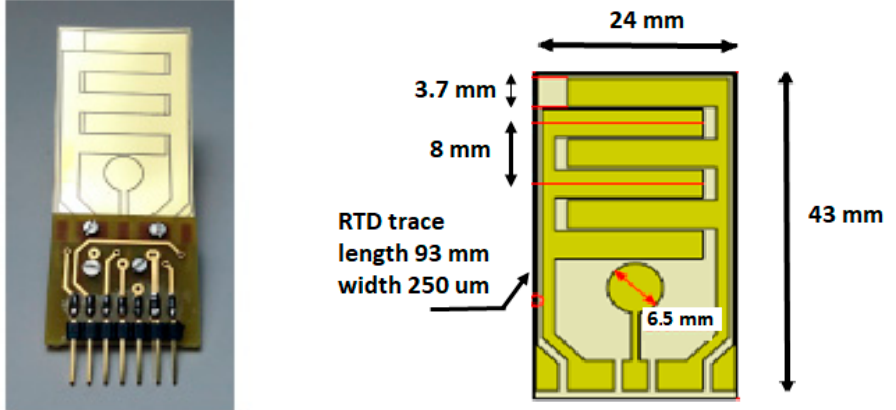
Figure 6. ( Right ) Multifunctional sensor: interdigital transducers (IDT) for active mode with finger pitch 8 mm, circular sensor with diameter 6.5 mm for impact sensing, resistive temperature device (RTD) for temperature monitoring with length (43 + 43 + 24) mm = 110 mm; ( Left ) dimensional drawing of the fabricated device by laser ablation of the metallization.